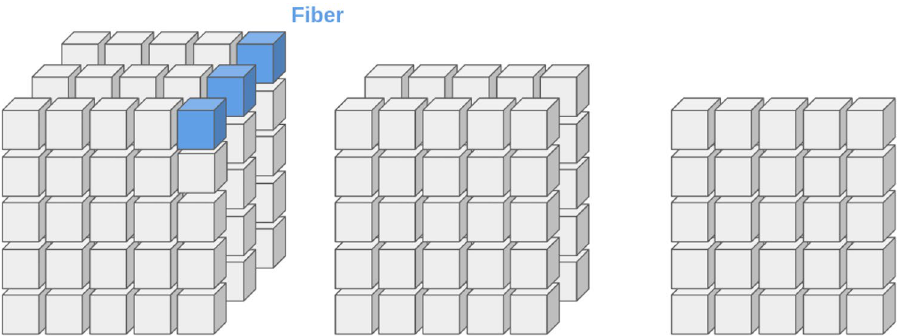
Figure 7. On-disk dynamic tensor-shaped data structure. For each image, we store a tensor with layers containing pixel-level matches to subsequent images based on the HybridFlow. Unmatched pixels in the second image are stored in the tensor data structure for the second image, which contains layers with pixel-level matches to the third image and onward. A fiber is shown in blue. Each cell contains the match of that pixel, i.e. the top right corner in all subsequent images. Reconstruction is reduced to triangulating the matches contained within each